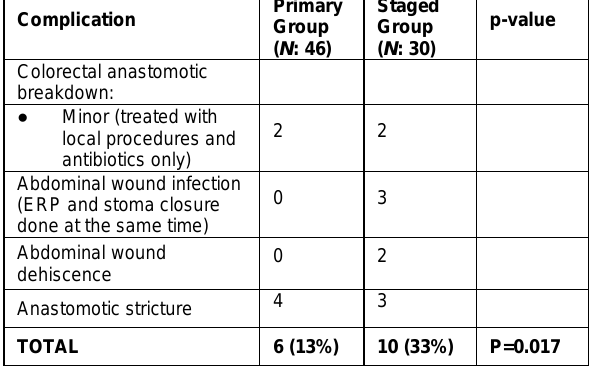
Table 2: Minor Perioperative complications